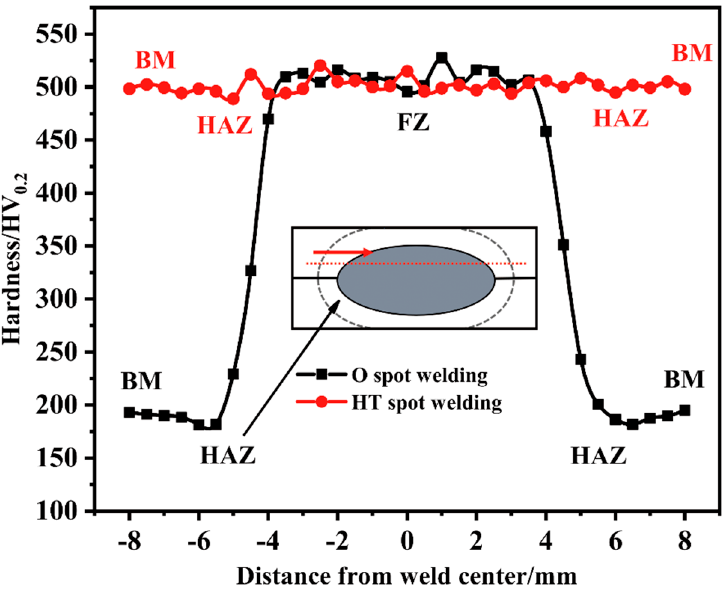
Figure 5. Hardness profiles of the O welding spot and the HT welding spot.